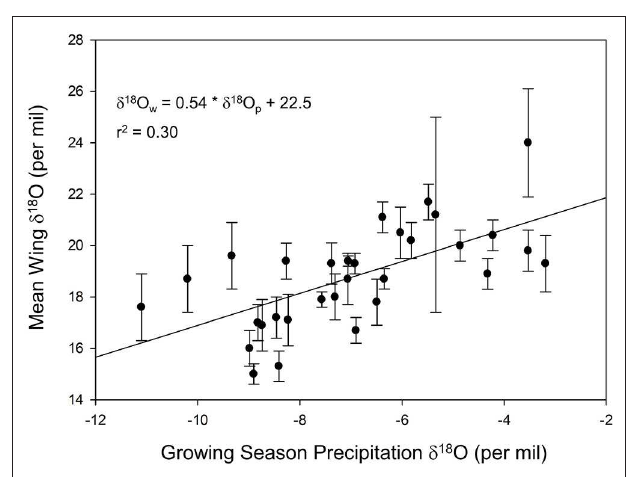
FIGURE 2 | Relationship between monarch δ 18 O w and amount-weighted mean growing-season average δ 18 O p (Bowen et al., 2005) for monarchs raised outdoors at 31 known sites ( Table 1 ) throughout their range in 1996.